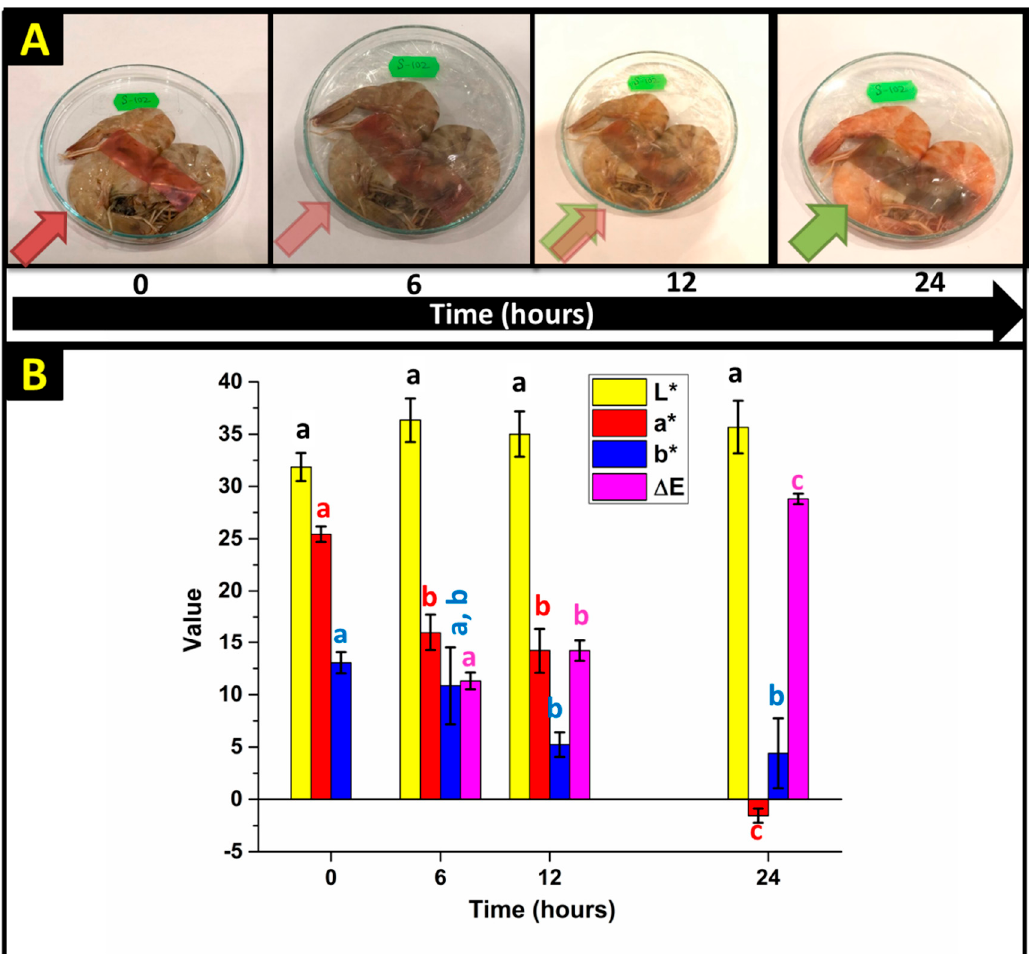
Figure 14. ( A ) Color change of PVA-15 NCFs in contact with shrimp samples exposed to air during the test period of 24 h. The added arrows indicate the color of the corresponding NCFs. ( B ) The corresponding values for the color parameters (L*, a* and b*) and color difference ( ∆ E) for the NCF used in the shrimp spoilage test at different time intervals. The results are the means of three determinations ± standard deviation. Values with the same letter in the same row do not differ statistically by Tukey’s test ( p ≤ 0.05).